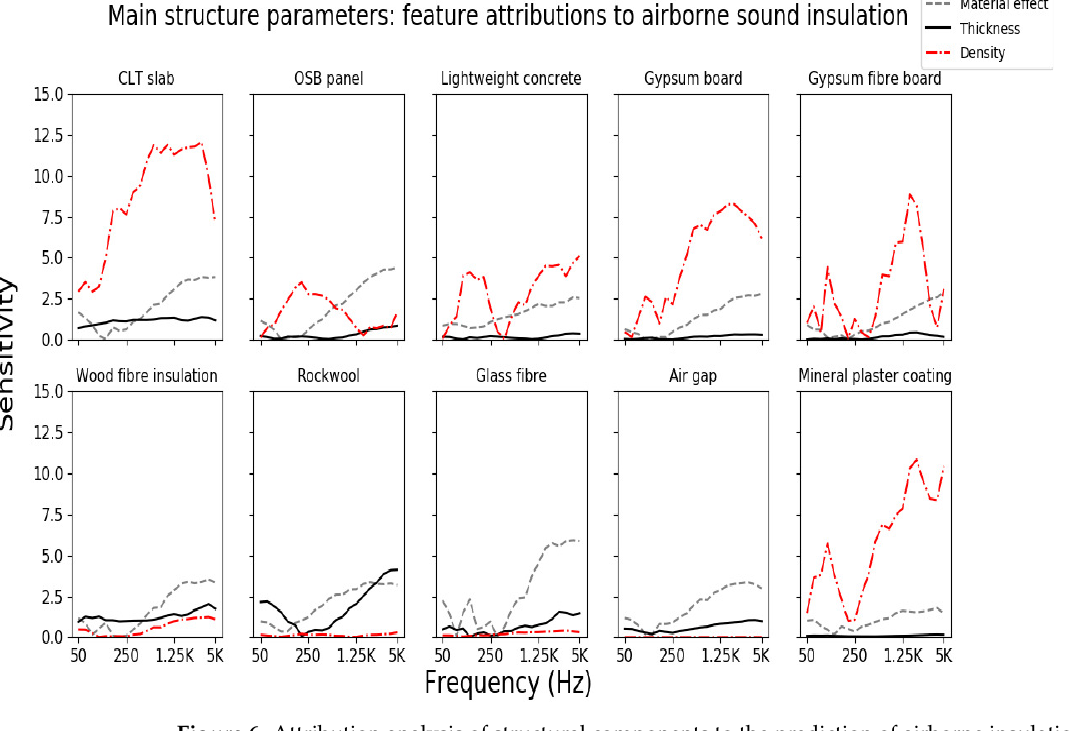
Figure 6. Attribution analysis of structural components to the prediction of airborne insulation curves.